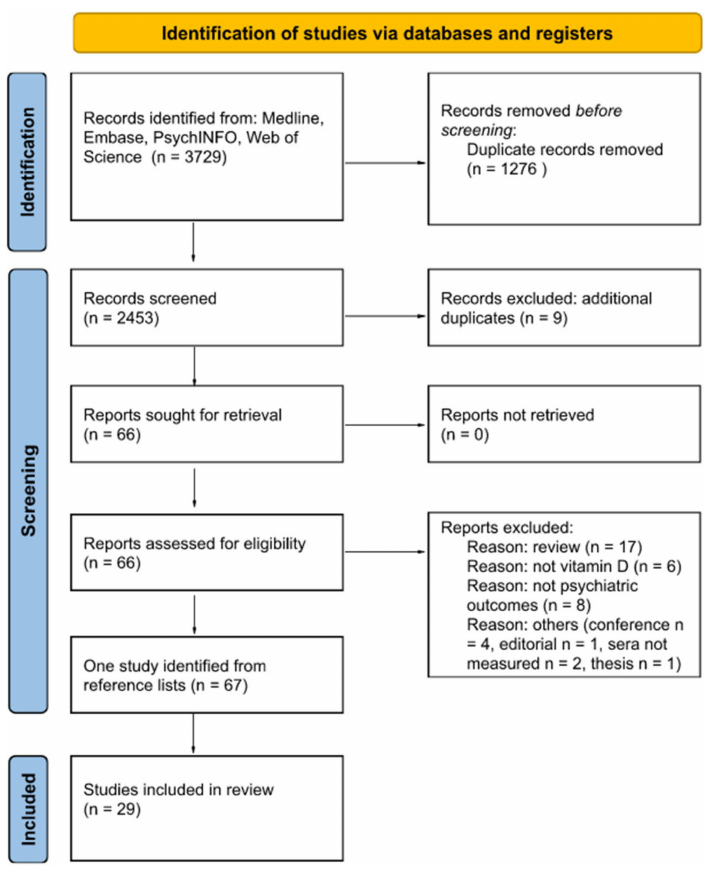
Figure 1. PRISMA flow diagram of the